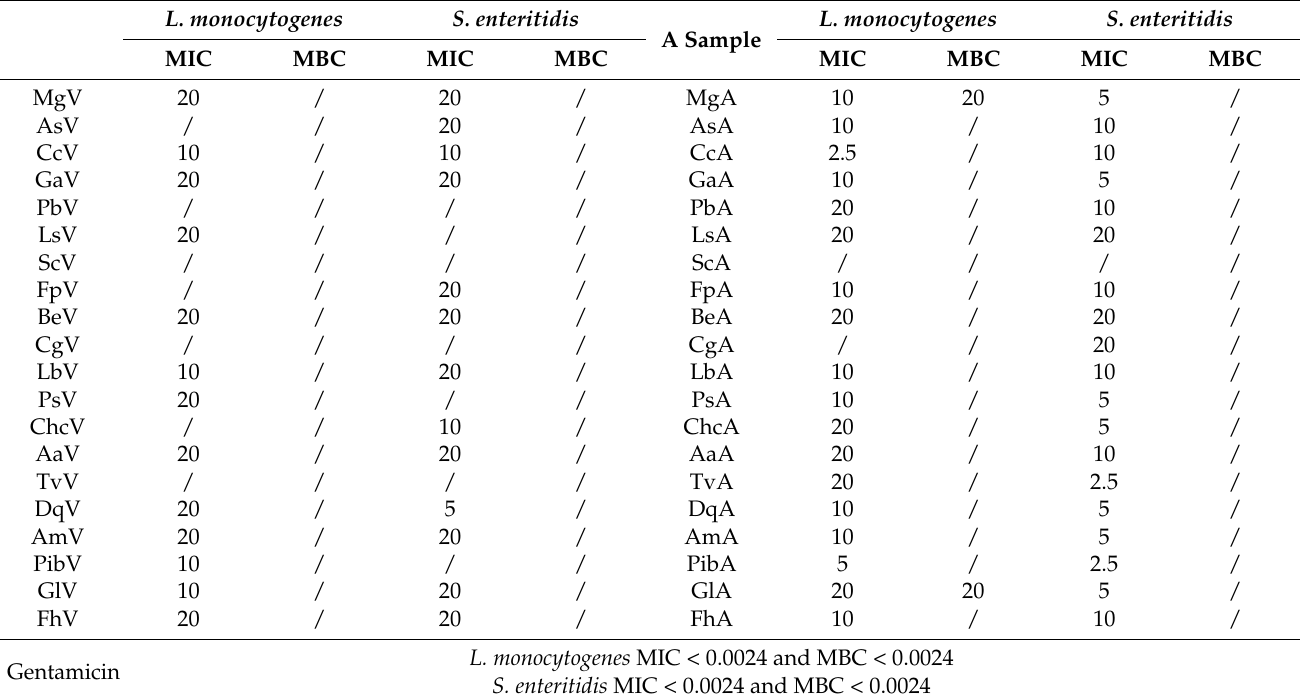
Table 1. Antimicrobial activity of mushroom extracts toward L. monocytogenes ATCC 19111 and S. enteritidis ATCC 13076, expressed as minimal inhibitory concentration (MIC) and minimal bactericidal concentration (MBC) expressed in